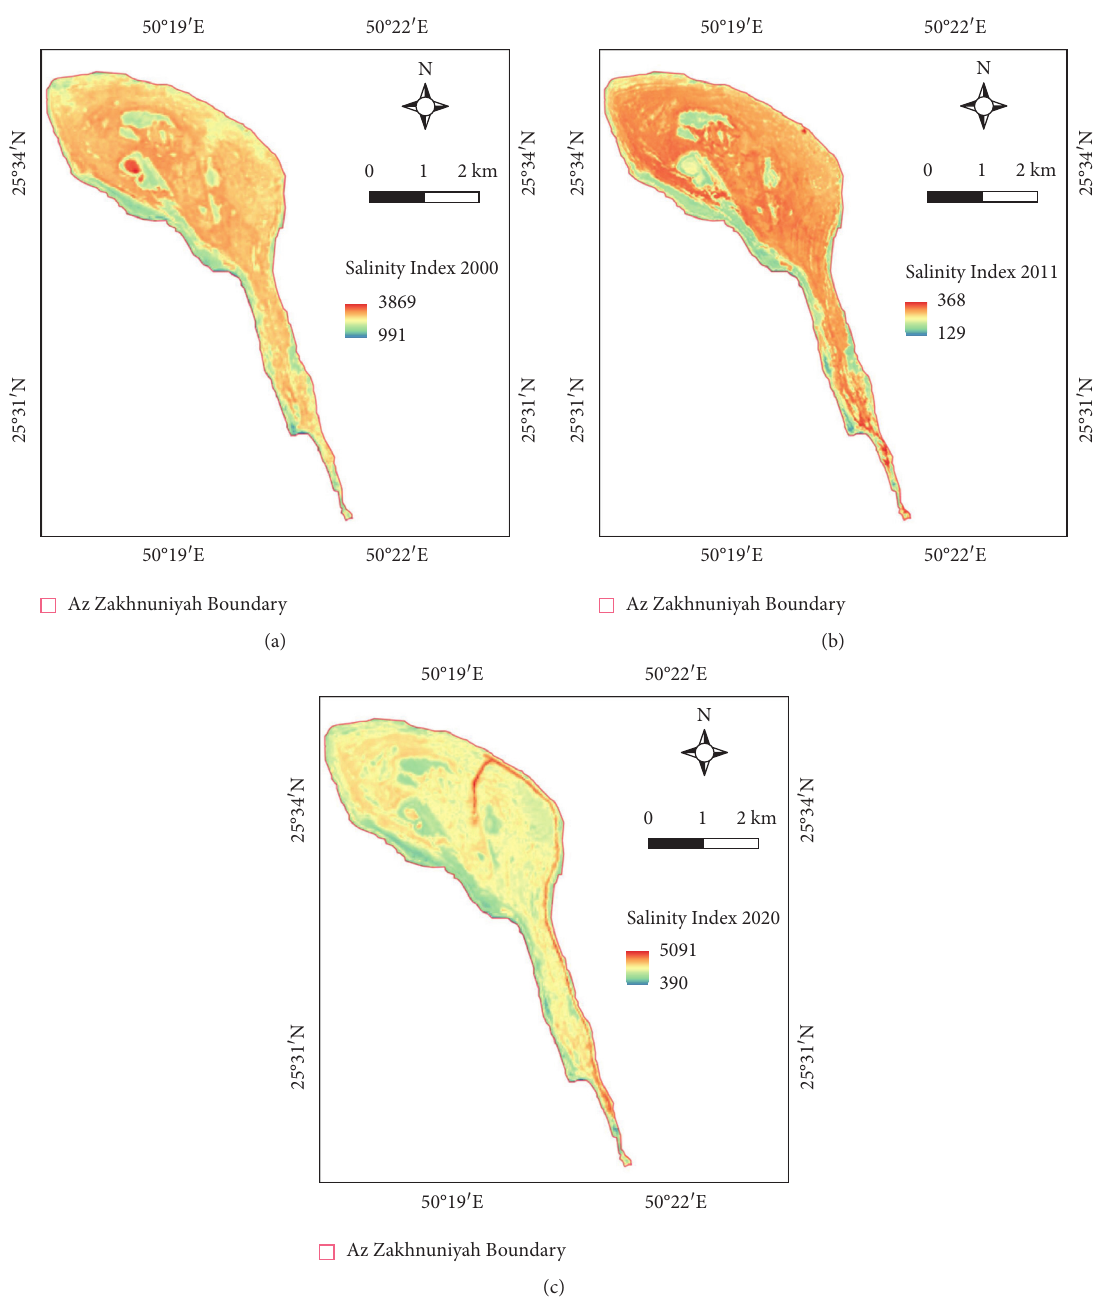
Figure 10: Salinity index (SI) map of (a) 2000, (b) 2011, and (c)